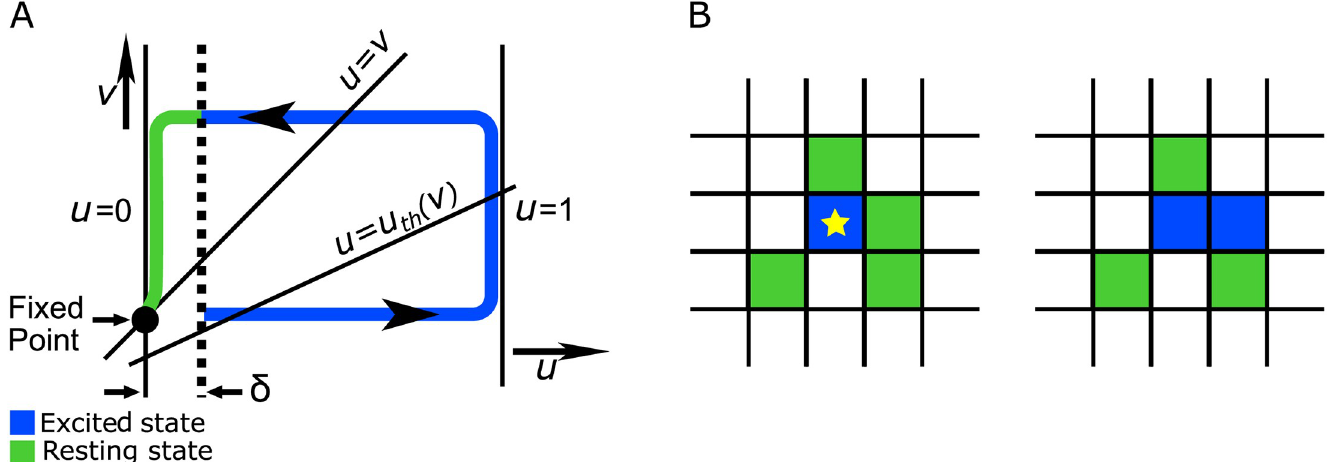
Fig 1. (Color online) schematic illustration of local dynamics. Corresponding dynamics of the excitable system in uv -plane is depicted by its nullclines. The u nullcline includes three separate lines: u = 0, u = 1 and u = ( v + b )/ a , while the line u = v is the v nullcline. The dotted line indicates the boundary layer δ which all the initial conditions within it decay to the fixed point. The itinerary in the uv - plane starts haphazardly once the value of u exceeds the amount of δ . Eventually, the itinerary returns to the fixed point after passing a large excursion, adapted from [24] (A). The medium consists of excitable cells spatially connected to each other by a diffusion-like coupling. An exited cell (the blue asterisk unite) is capable of triggering excitation through its neighbors with the help of diffusing cAMP molecules (B).